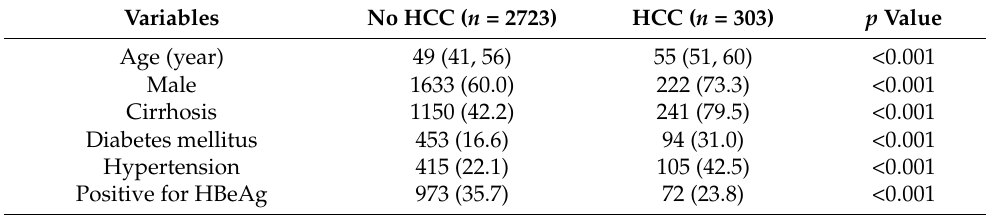
Table 2. Comparison of baseline clinical characteristics between patients with HCC and